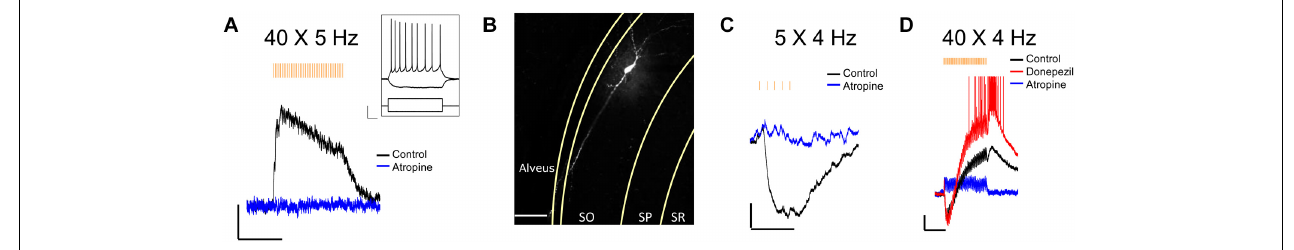
FIGURE 2 | Optogenetically released ACh in hippocampal slice evokes predictable response types in CA1 interneurons. (A) Representative trace showing a stratum oriens interneuron depolarized in response to 40 X 5 Hz stimulation; Scale bar: x = 5000 ms, y = 2 mV; Inset changes in membrane potential of the same neuron in response to depolarizing (+200 pA) and hyperpolarizing (–200 pA) current injections; Scale bar: x = 100 ms, y = 20 mV. (B) Fluorescent image of the same neuron as in (A) after post hoc staining with streptavidin conjugated to AlexaFluor 633 to label biocytin; Scale bar = 50 microns. (C,D) Representative traces showing ACh-mediated hyperpolarization ( C ; scale bar: x = 1000 ms; y = 2 mV), and biphasic response ( D ; scale bars: x = 5000 ms; y = 2